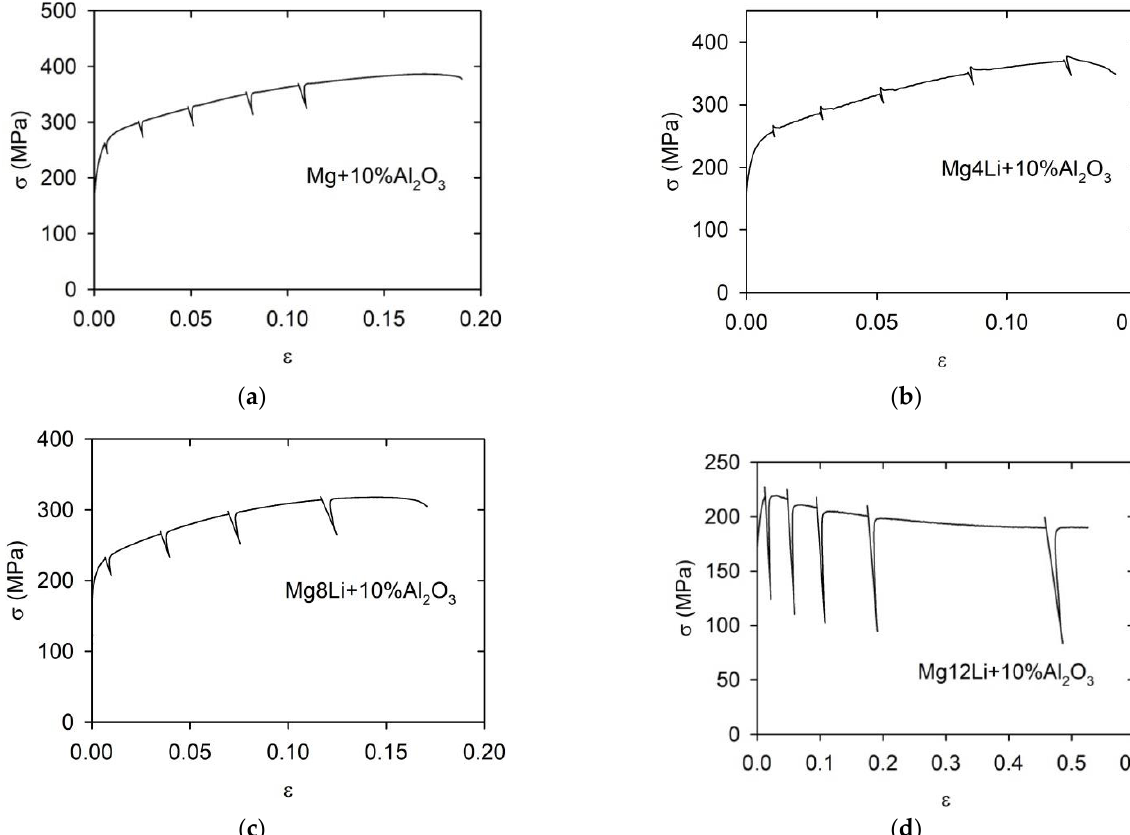
Figure 3. Stress–strain curves where stress-relaxation curves were cut: ( a ) Mg, ( b ) Mg4Li, ( c ) Mg8Li, and ( d ) Mg12Li. The series of SR curves normalized to the starting stress σ (0) are shown in Figure 4a–d. While the minimum stress decrease observed in the Mg4Li composite was only several percent, in the Mg12Li composite, the stress decrease achieved was ~50%.